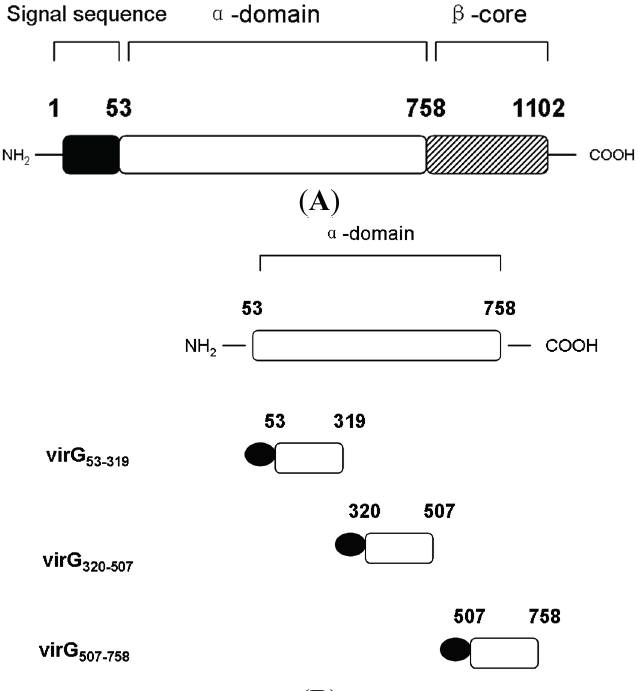
Figure 5. Schematic diagram of the structure of VirG and construction of S- α -domain fusion proteins. ( A ) The structure of VirG contains three domains: N-terminal signal sequence, α -domain and β -core. ( B ) The portions of VirG α -domain fusing the S tag by the pET32a(+)S vector.